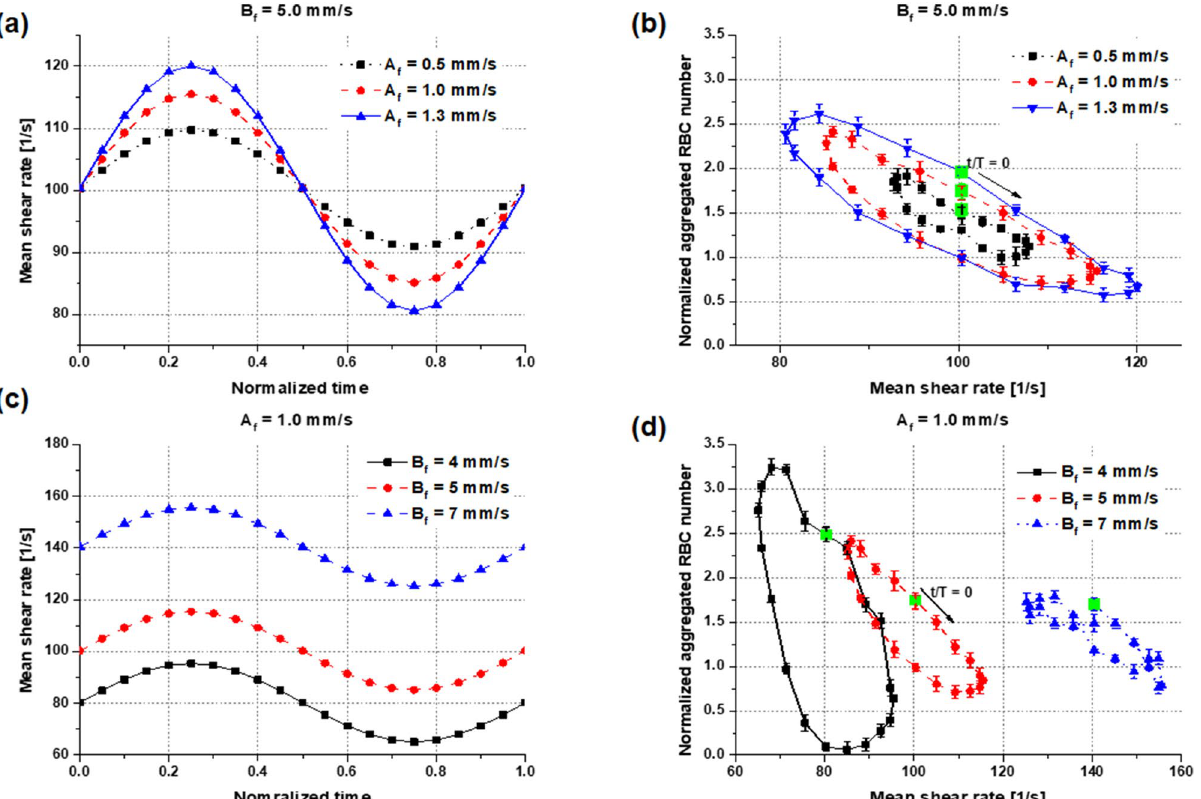
Figure 7. Mean shear rate and normalized aggregated RBC numbers in an ROI ( 0.1mm of both tube diameter and length near the tube center). ( a ) Mean shear rate with normalized time over a cyclic period for three different amplitudes of velocity (0.5, 1.0, and 1.3 mm/s) with a fixed mean flow velocity of 5 mm/s. ( b ) Normalized aggregated RBC numbers averaged over five pulsatile cycles as a function of mean shear rate at three different hydrodynamic conditions. ( c ) and ( d ) are the same with ( a ) and ( b ), respectively, but for the different mean flow velocity from 4 to 7 mm/s with a fixed velocity amplitude of 1 mm/s. Symbols and error bars indicate the mean values and standard deviations over five cycles, respectively. From the start points (green symbols; t/T = 0), hysteresis loops show clockwise